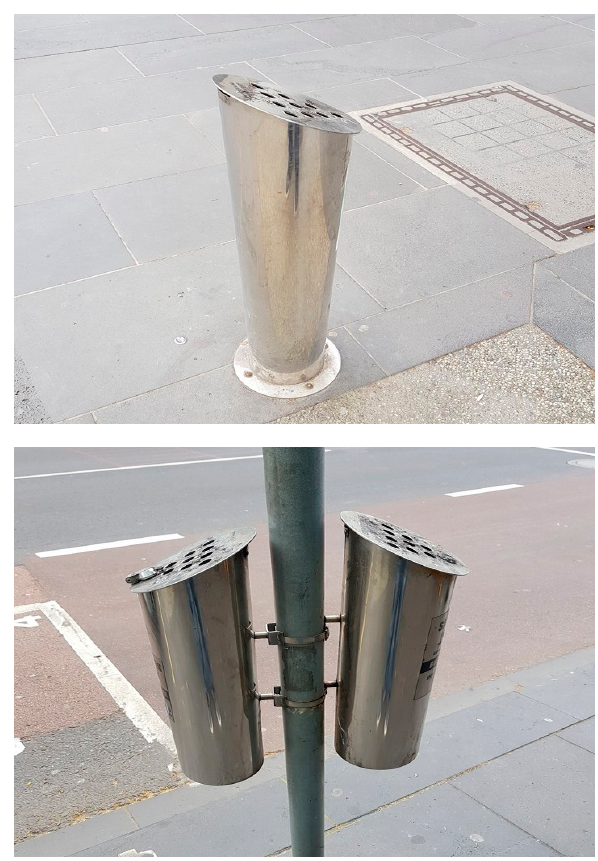
Figure 7. Typical CB Receptacles: free standing ( top ) and post mounted ( bottom ).